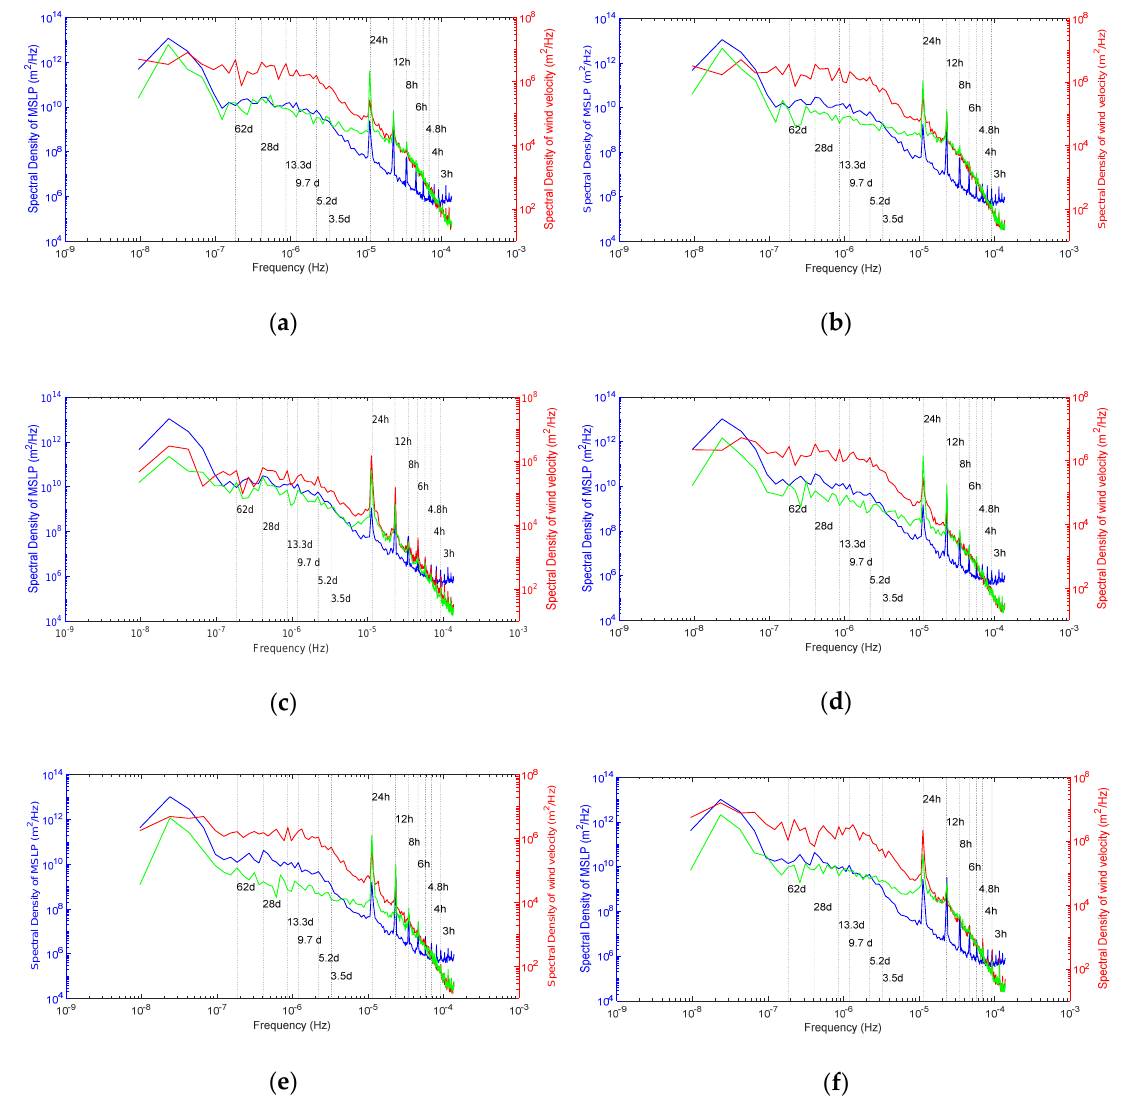
Figure 4. Spectral energy plot of wind speed components (major component: red, minor component: green) and MSLP (blue color) at ( a ) Deylam station; ( b ) Bushehr station; ( c ) Lavar station; ( d ) Kangan station; ( e ) Javad al-Aemmeh station; ( f ) Bostaneh station.